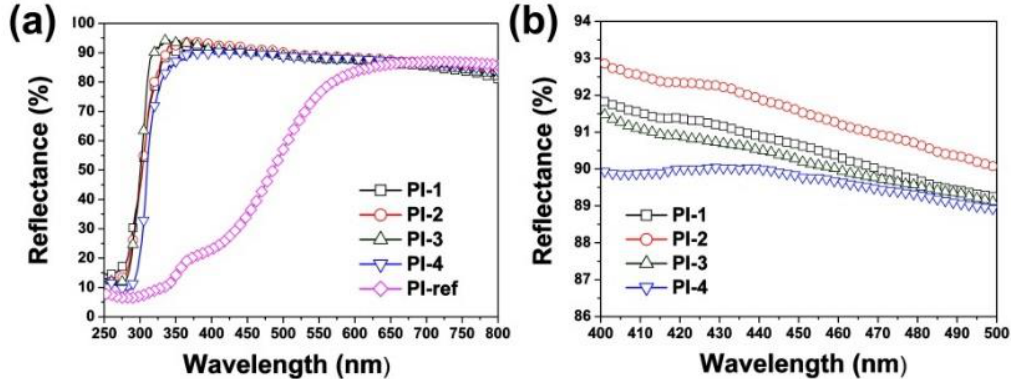
Figure 6. Macroscopic and microscopic morphology of PI samples. ( a ) Appearance of PI film; ( b ) appearance of PI membranes; ( c – f ) SEM images of PI-1, PI-2, PI-3, and PI-4 membranes, respectively; ( g ) SEM image of PI-ref NFM.